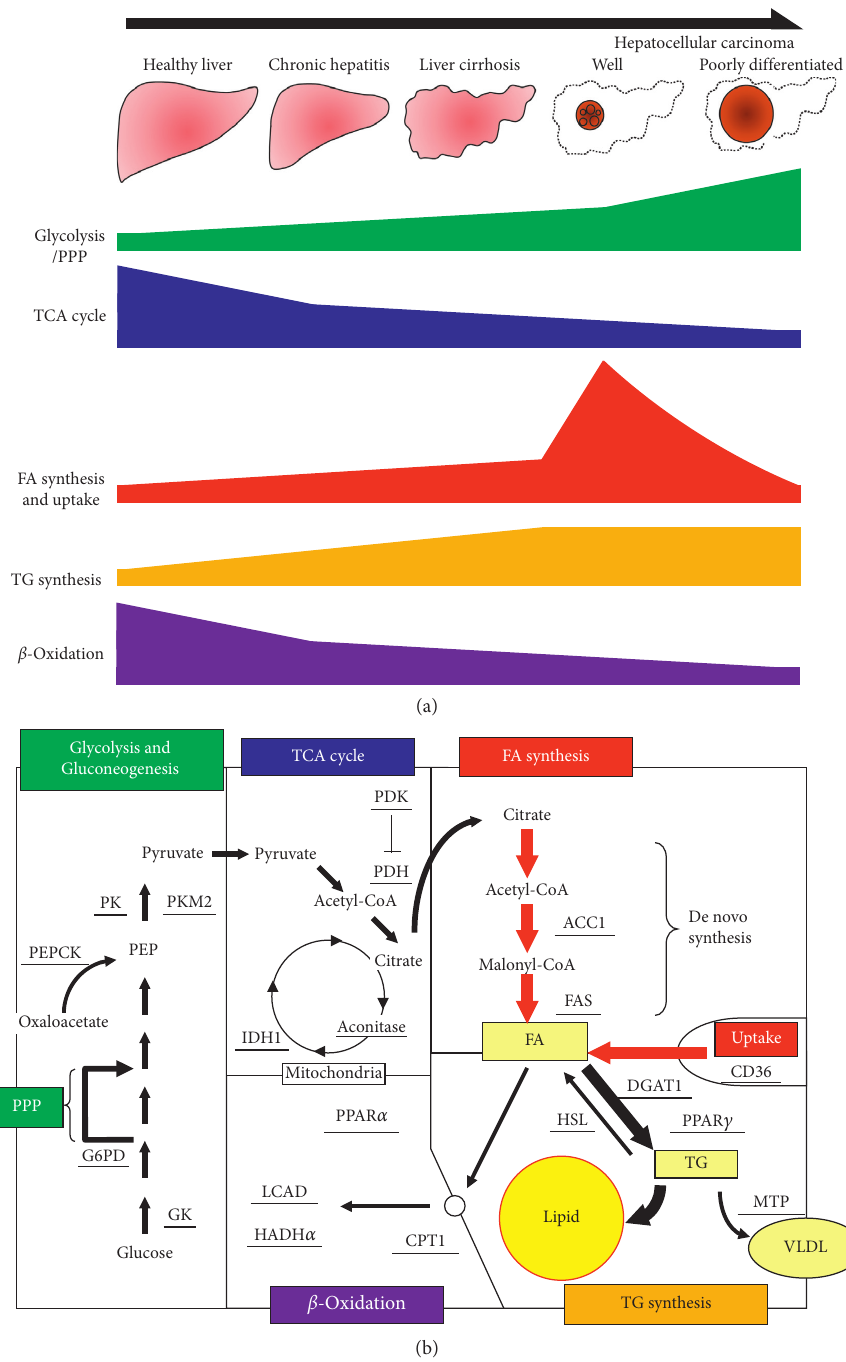
Figure 5: Schematic figures of metabolic alterations in HCC. (a) The schematic figure showing the metabolic alteration as liver disease progresses from normal liver, chronic hepatitis, cirrhosis, to well- and poorly differentiated HCC. Glycolysis and pentose phosphate pathway (PPP) were increased and the TCA cycle and β -oxidation were decreased throughout the disease progression course. FA synthesis and uptake were gradually increased until HCC development, while those of well-differentiated HCC were the highest and decreased as the degree of differentiation progressed. (b) Comprehensive schematic figure showing the metabolic features in the well-differentiated HCC. The thick arrows represent increased biochemical reactions indicated by gene expression analysis. GK, glucokinase; G6PD, glucose-6- phosphate dehydrogenase; PEP, phosphoenolpyruvate; PEPCK, phosphoenolpyruvate carboxykinase; PK, pyruvate kinase; PDH, pyruvate dehydrogenase; PDK, pyruvate dehydrogenase kinase; IDH, isocitrate dehydrogenase; ACC, acetyl-coenzyme A carboxylase; FAS, fatty acid synthase; PPAR, peroxisome proliferator-activated receptor; DGAT, diacylglycerol acyltransferase; HSL, hormone-sensitive lipase; MTP, microsomal triglyceride transfer protein; CPT, carnitine palmitoyltransferase; LCAD, long chain acyl-coenzyme A dehydrogenase; HADH, hydroxyacyl-coenzyme A